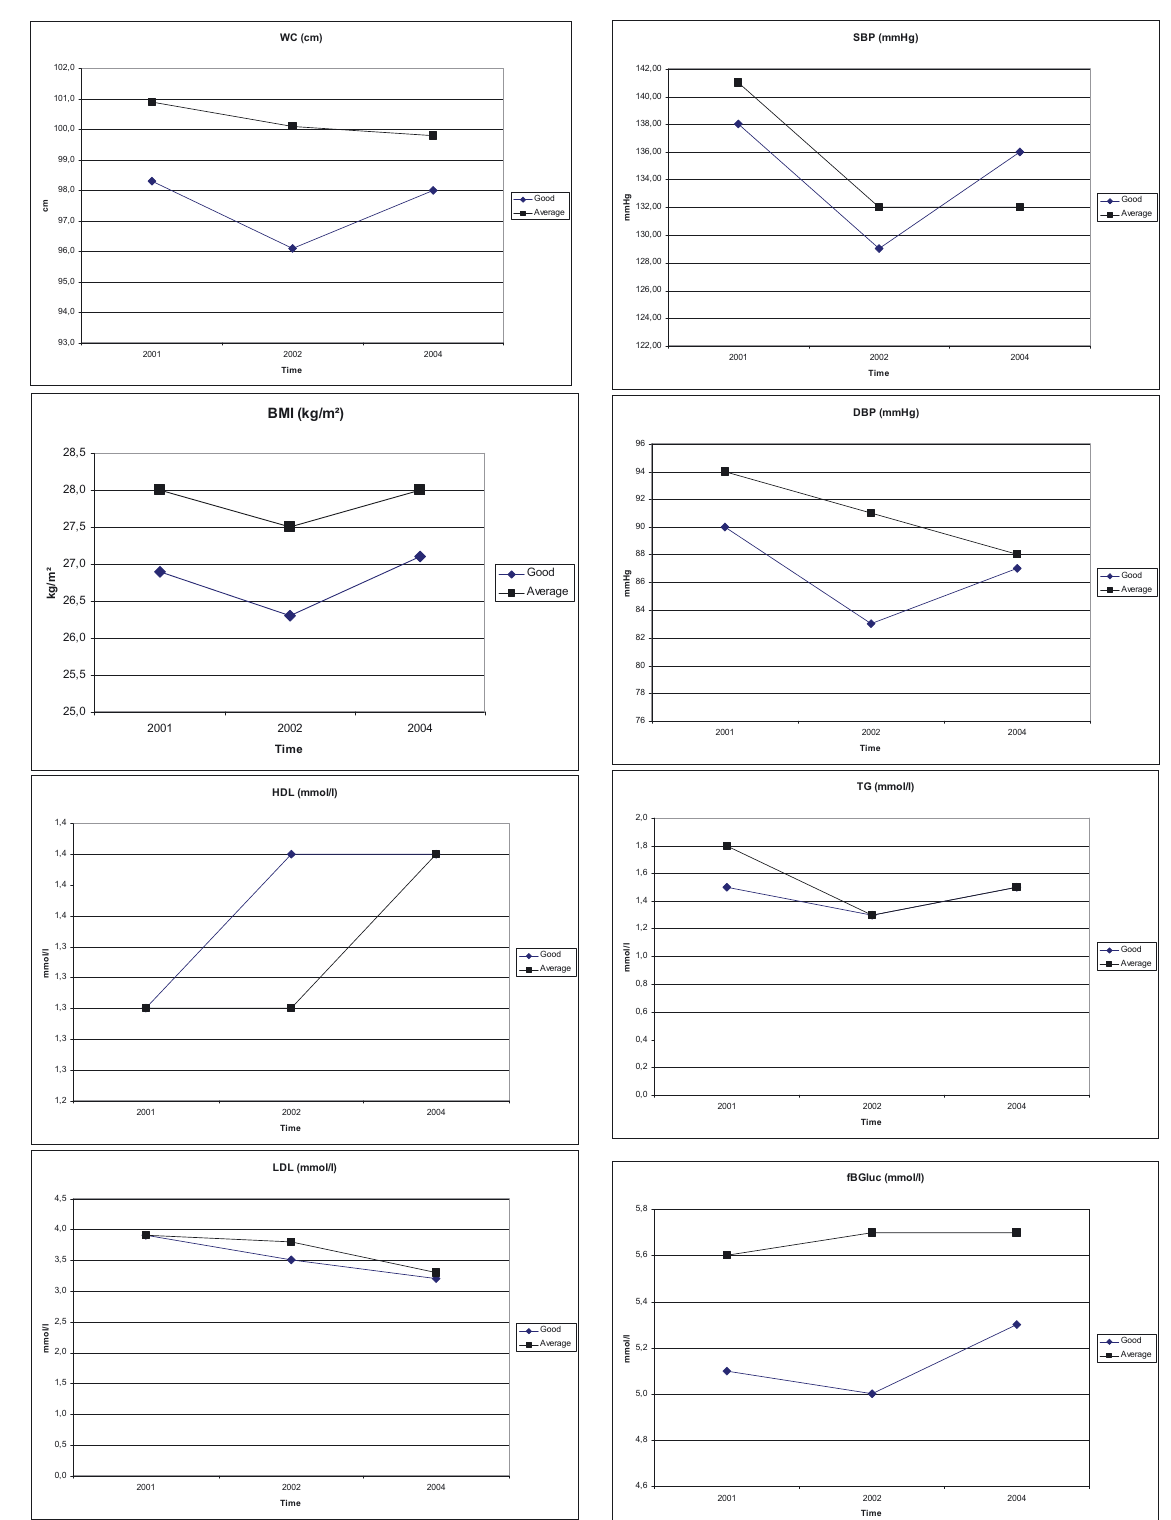
Figure 2. Risk factors in the groups of self-rated